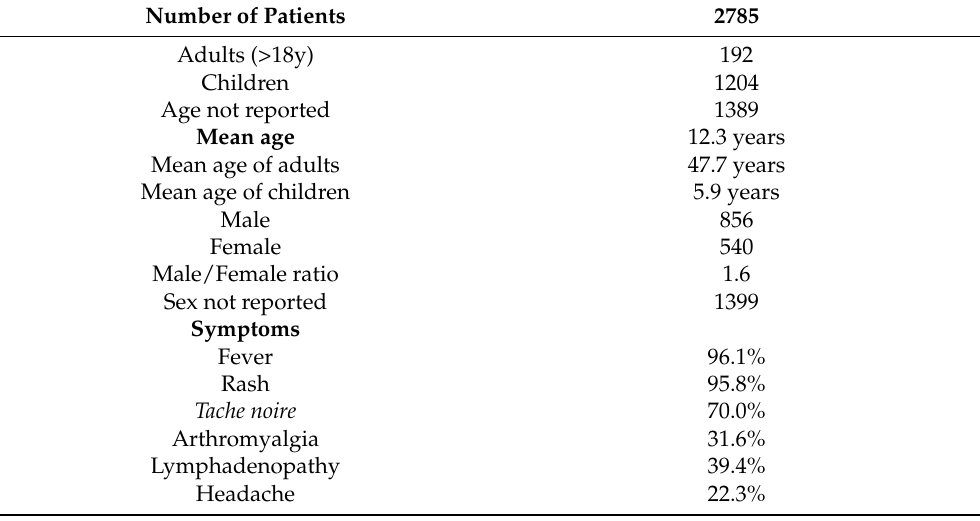
Table 1. Demographic and clinical features of patients with diagnosis of MSF.